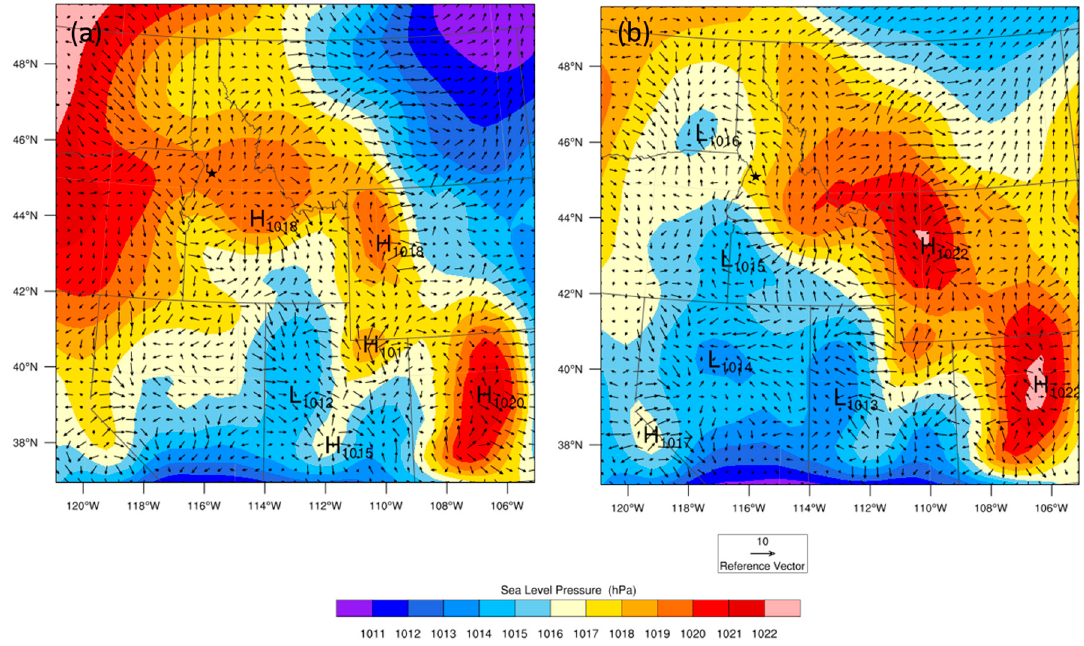
Figure 7. Mean sea level pressure and 10-m winds simulated in the 36 km domain at 0600 LT on: ( a ) non-event day 18 August; and ( b ) event day 17 August. The study area is indicated with a star.